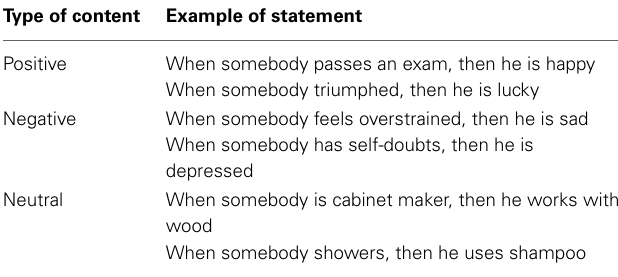
Table 1 | Examples for negative (mirroring failure situations), positive (mirroring success situations) and neutral rules (words and sentences were presented in German language in all